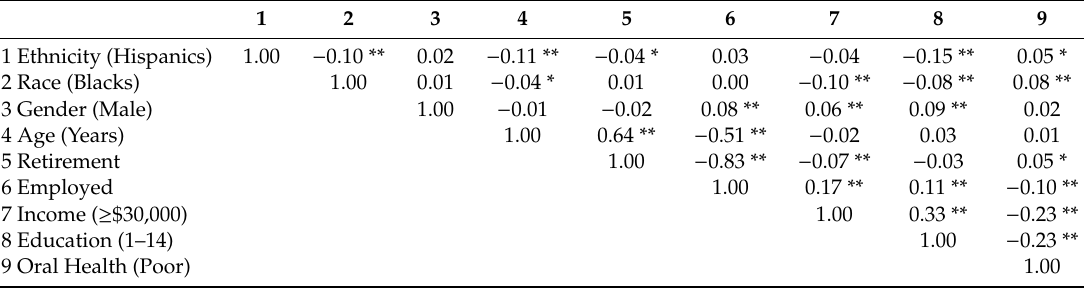
Table 2. Spearman correlations in the pooled